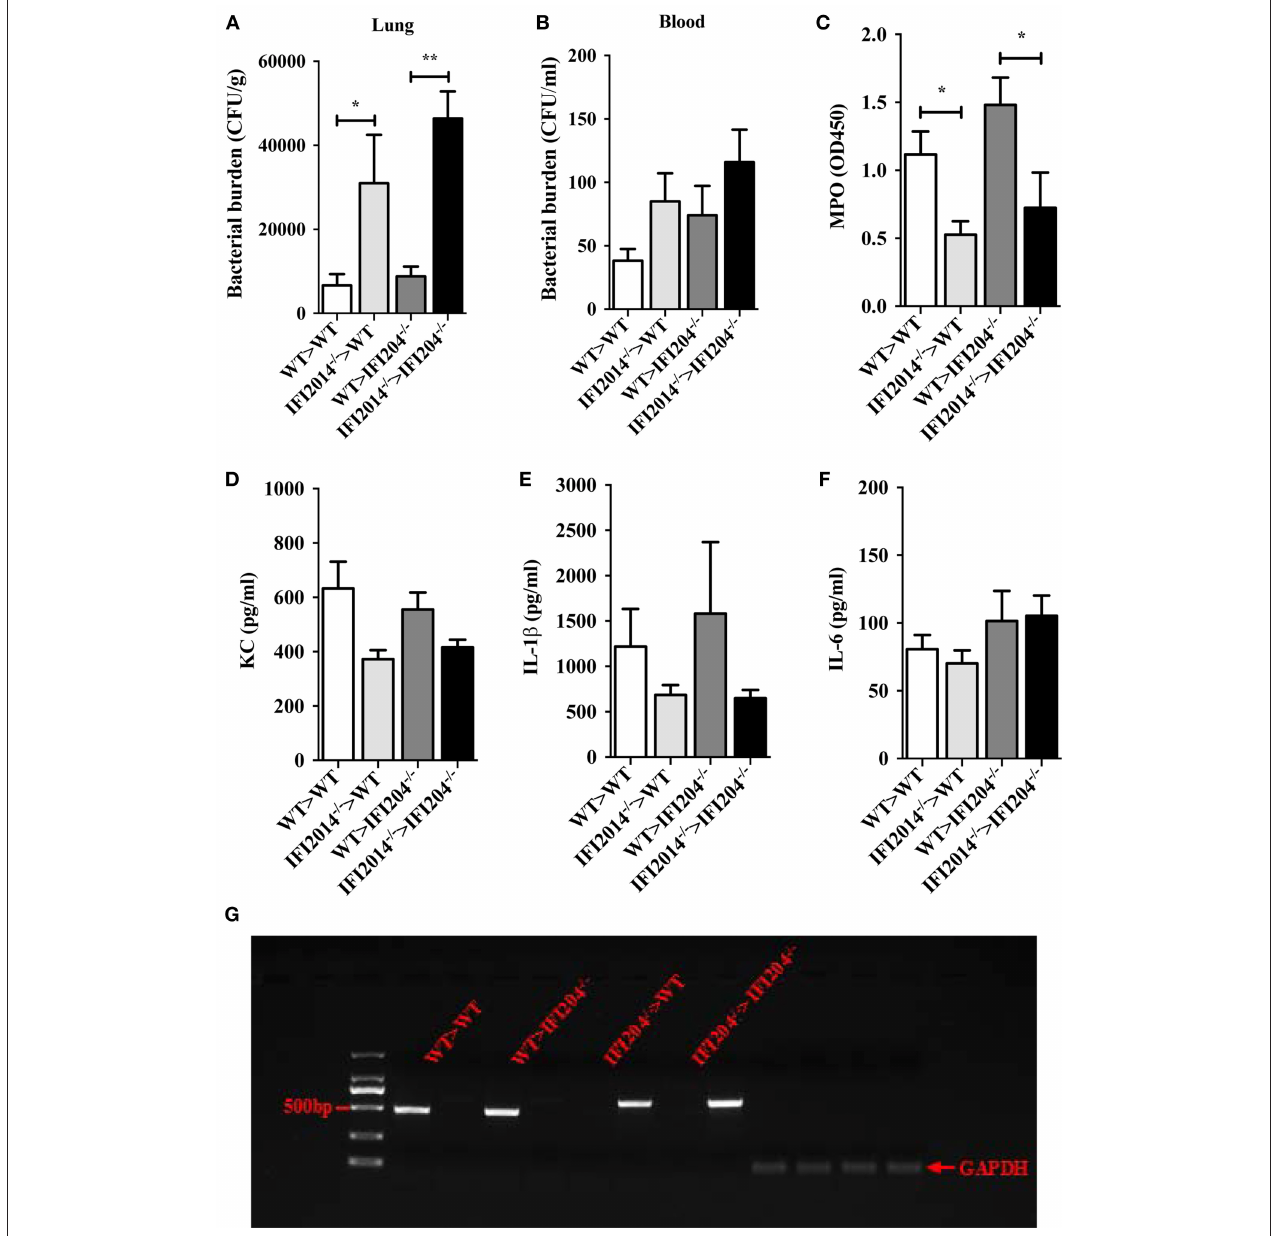
FIGURE 8 | Adoptive transfer of WT BM cells protects IFI204-deficient mice against Staphylococcus infection. Bone marrow cells isolated from WT or IFI204 − / − mice were adoptively transferred to irradiated IFI204 − / − or WT recipient mice. The recipient mice were then infected nasally with Staphylococcus (1 × 10 8 CFU, n = 4–6 each group) for 24h. (A,B) Homogenized lung tissue and blood were subjected to plating serial dilution for bacterial loads. (C) Neutrophil activity in lung was determined by the amount of MPO. (D–F) The release of KC, IL-6, IL-1 β in lung were determined by ELISA. (G) Efficient reconstitution by donor bone marrow cells was confirmed by PCR for the IFI204 gene in splenocytes. All data are shown as mean ± SEM. Student’s t -test was performed. * p < 0.05; ** p <